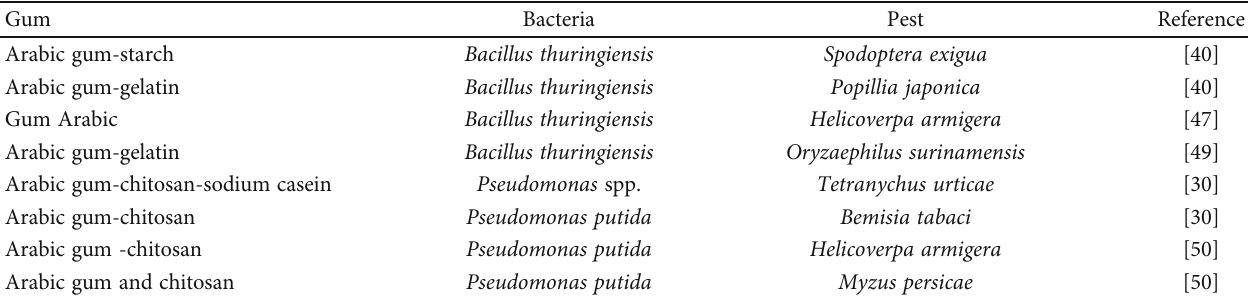
Table 2: Use of di ff erent gums and polymers to encapsulate other bacteria against